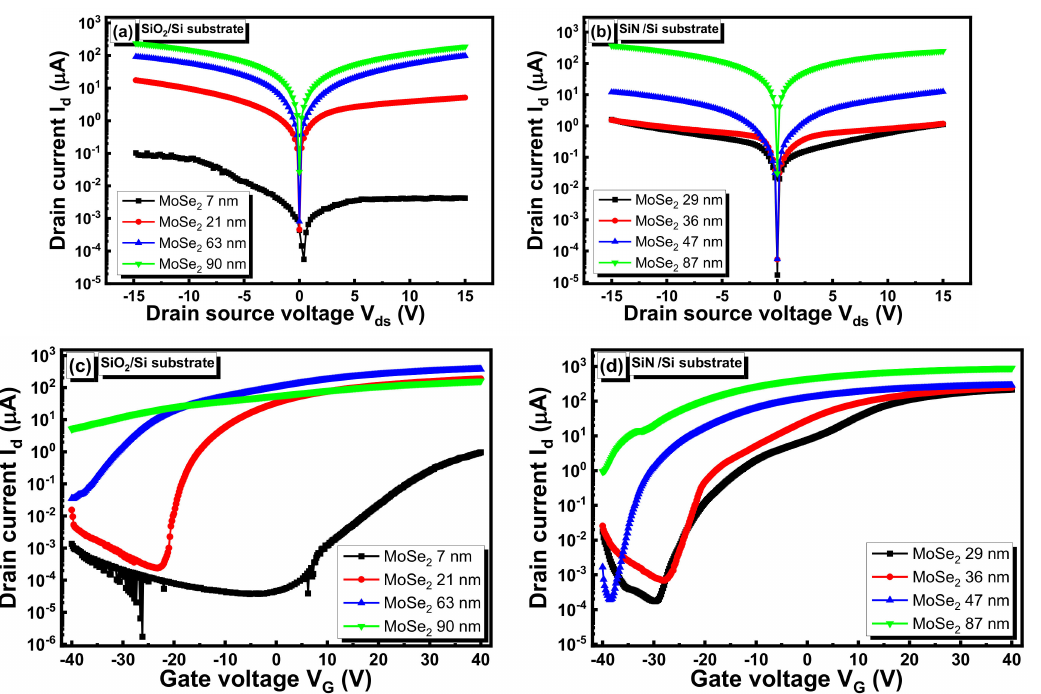
Figure 1. I d -V ds characteristics of the fabricated devices on ( a ) SiO 2 /Si substrates and ( b ) SiN/Si substrates, and transfer curves of the fabricated devices on ( c ) SiO 2 /Si substrates and ( d ) SiN/Si substrates.